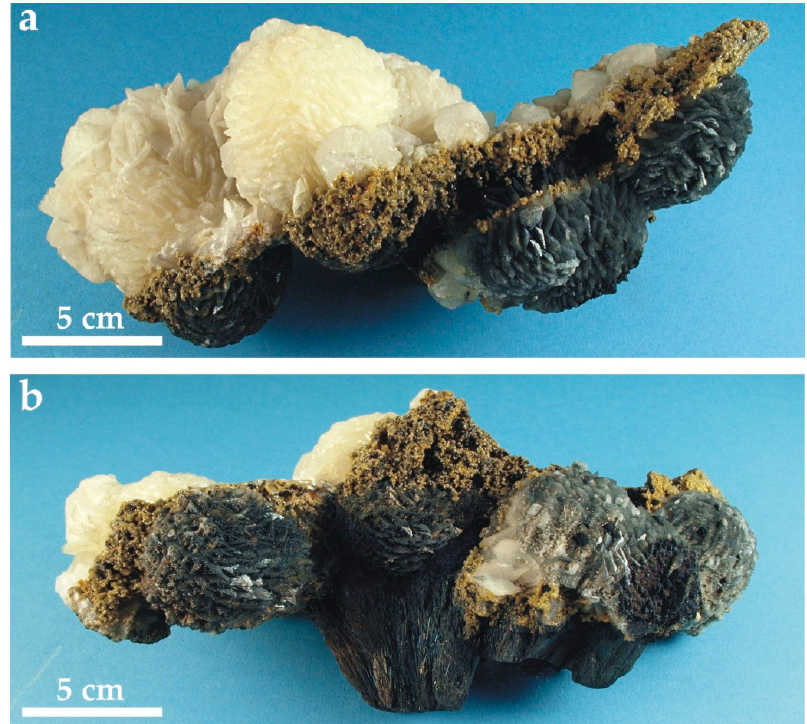
Figure 12. White and black calcite spheres from Herja, sample 9096; MusMin. ( a ) White and black calcite spheres with the diameter ranging from approximately 4 to 6 cm, formed of individual flatten rhombohedra; note the clear distinction between the white and black parts, which are separated by a planar surface partly masked by late siderite deposition; ( b ) Tilted view of the black section of the sample that reveals the presence of trunk-like berthierite fibroradial massive aggregates; late white calcite rhombohedra occur on the siderite from the black side of the sample.